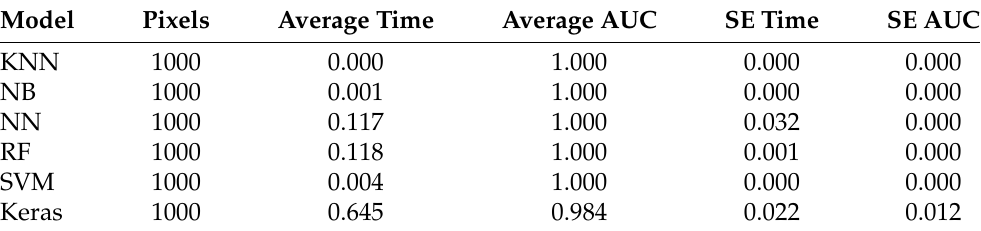
Figure 1. Average training time for each algorithm (in s), according with the proposed range of pixels selected. Table 1. Average training time and AUC for each algorithm under different numbers of